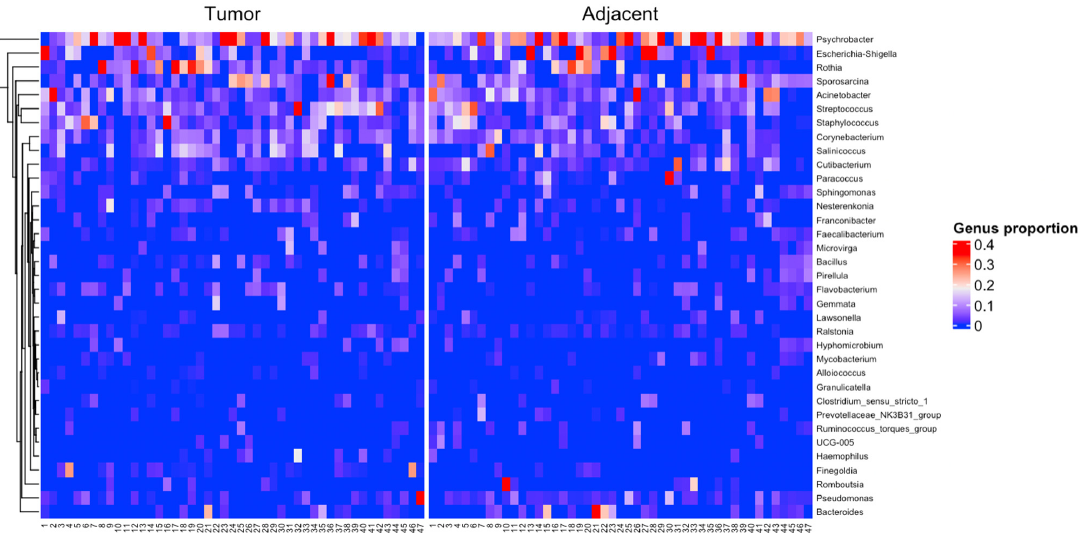
Figure 5. Heatmap illustrating levels of genus in breast by sample grouped into tumor and adjacent samples. The rare genus is shown in the blue color while the red color represents abundant genus. The dendogram shows the hierarchical clustering of genus.